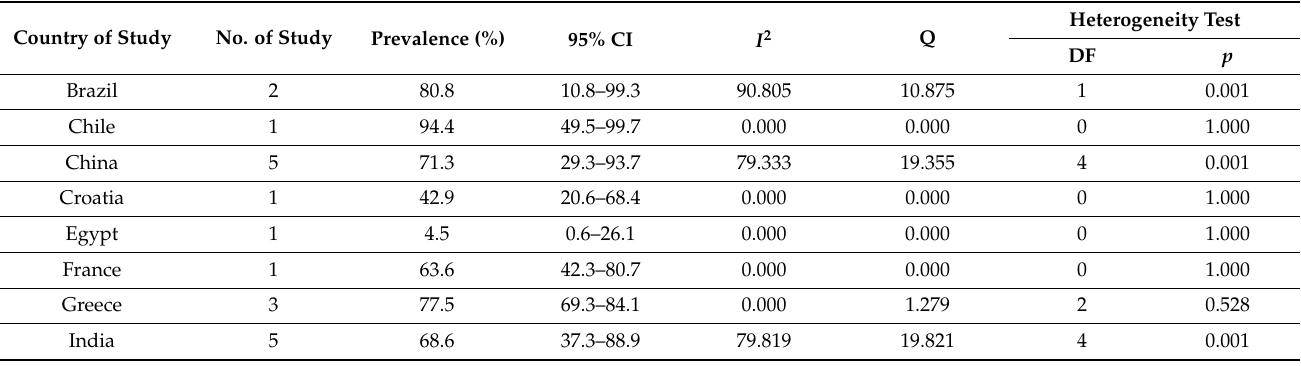
Table 2. Subgroup analysis of prevalence of mutated colistin-resistant K. pneumoniae (ColRkp) according to countries of studies.